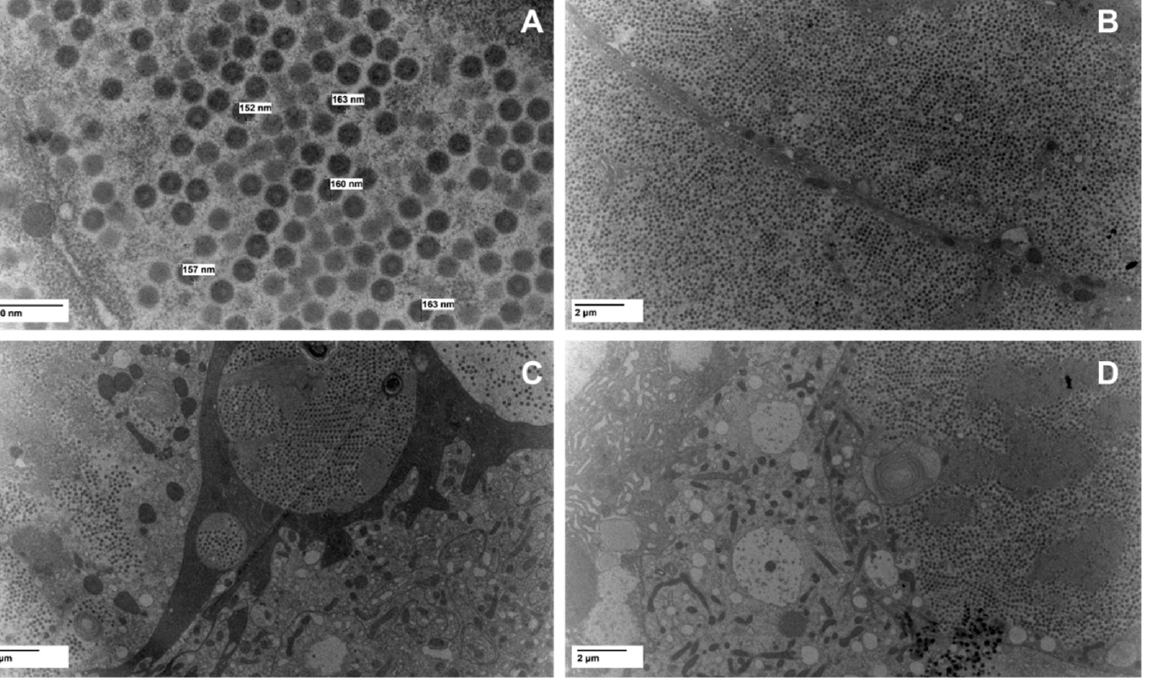
Figure 1. TEM images of fat body tissues dissected from a diseased cricket infected with cricket iridovirus (CrIV) at ( A ) 30,000× magnification and ( B – D ) 4800× magnification.